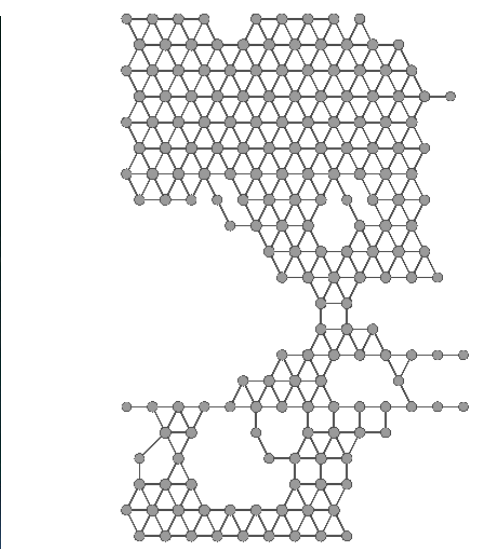
Figure 2. Physical location of a city represented as a vertex.